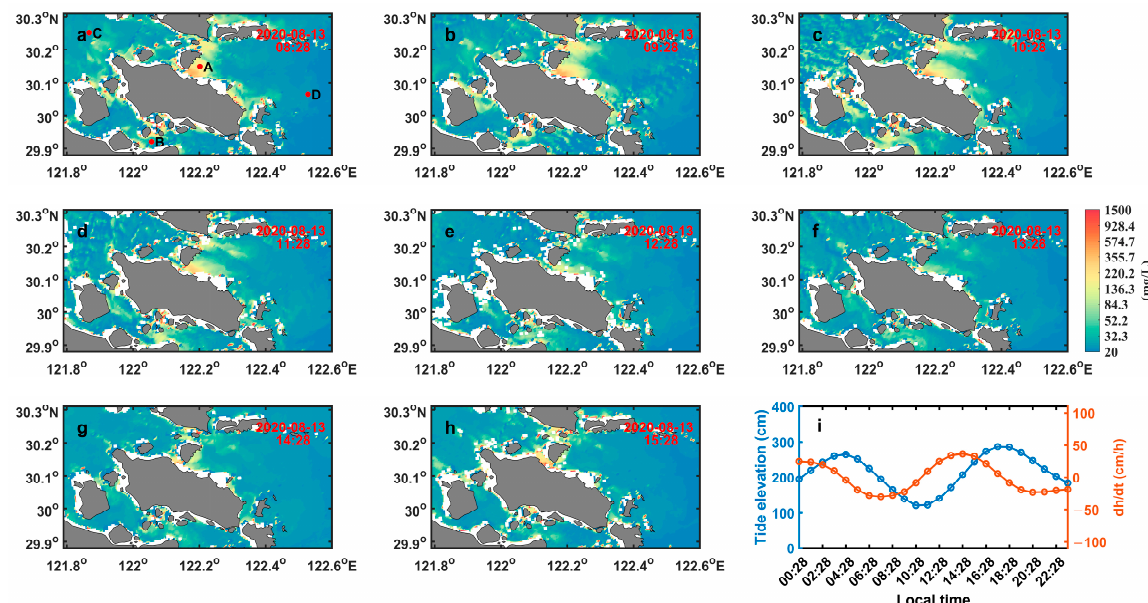
Figure 10. ( a – h ) Hourly maps of the GOCI-retrieved SSC in the Zhoushan Archipelago during neap tide on 13 August 2020. The red dots in ( a ) are the selected points for the analysis. ( i ) The simulated hourly tide elevation and temporal variation of tidal level, dh/dt , at point A.